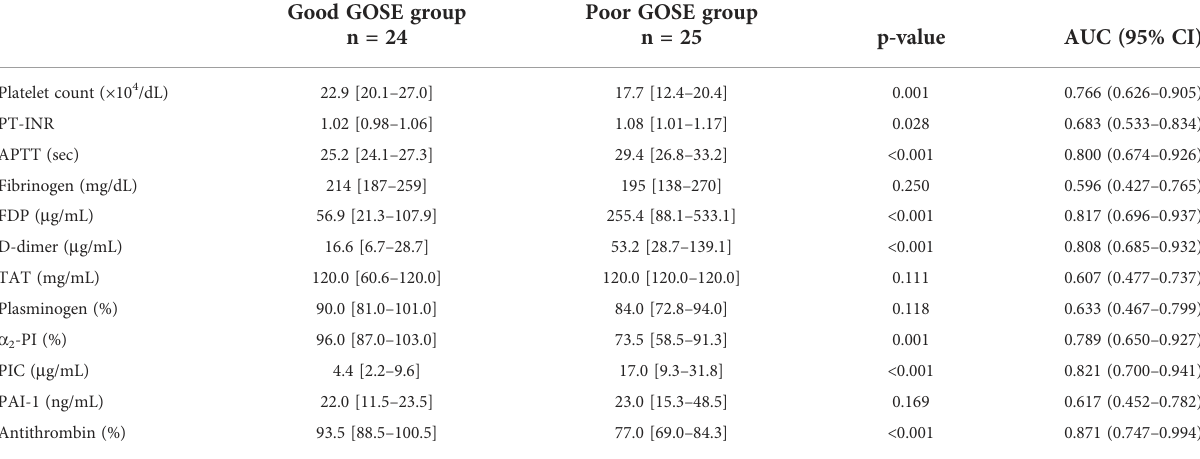
TABLE 2 Biomarkers of good and poor GOSE groups 1 h after injury.